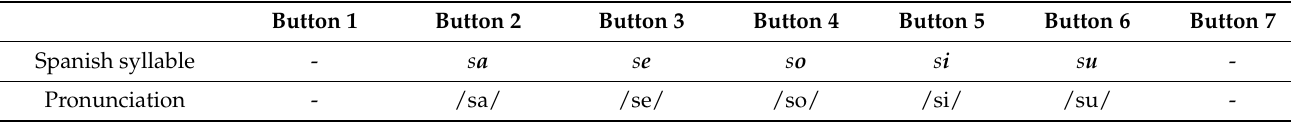
Table 2. The Response Pad visual aid in Spanish for the MSM group.